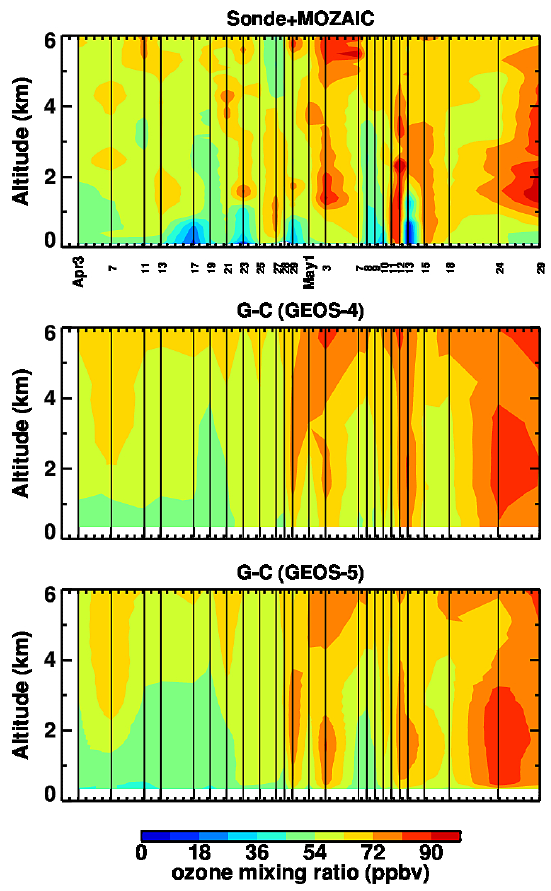
Figure 5. Time–height cross sections of lower-tropospheric O 3 mixing ratios (ppbv), as observed at Beijing during April–May 2005 by ozonesonde and MOZAIC aircraft in comparison with GEOS- Chem simulations driven by the GEOS-4 and GEOS-5 meteorolog- ical fields. Model daily outputs are sampled in the grid box nearest to Beijing for the dates (vertical lines) of ozonesonde